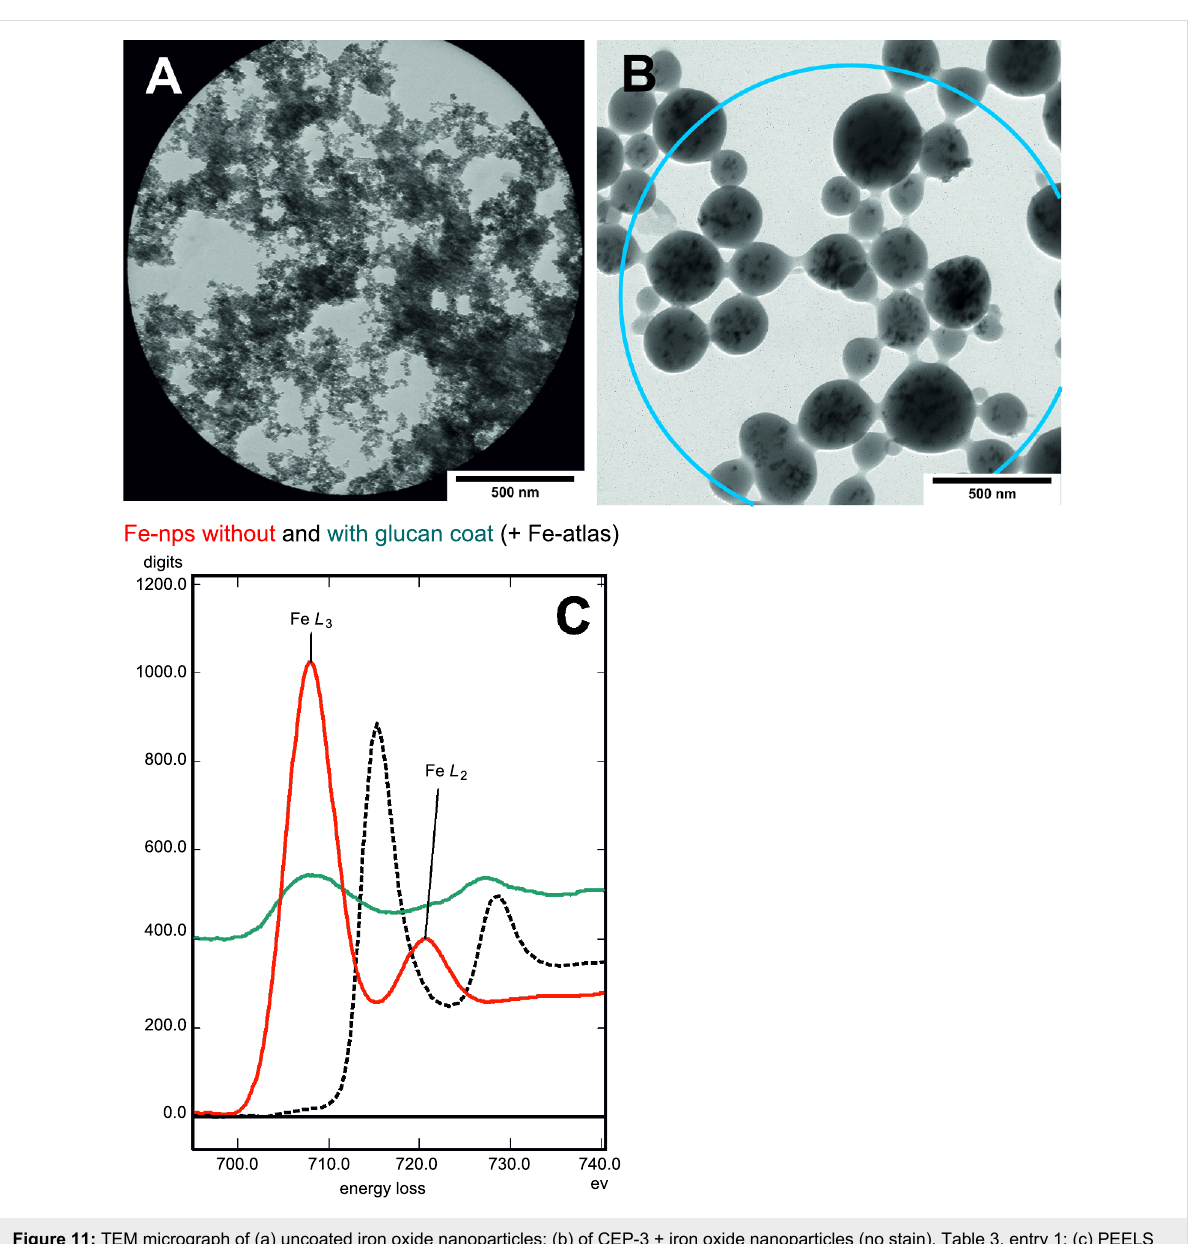
Figure 11: TEM micrograph of (a) uncoated iron oxide nanoparticles; (b) of CEP-3 + iron oxide nanoparticles (no stain), Table 3, entry 1; (c) PEELS measurements of uncoated iron oxide particles (red line), polysaccharide coated particles (blue line) and the Fe(0) atlas reference spectrum (black, dashed line); PEELS measuring areas are shown as aperture in A and circle in B; for details see